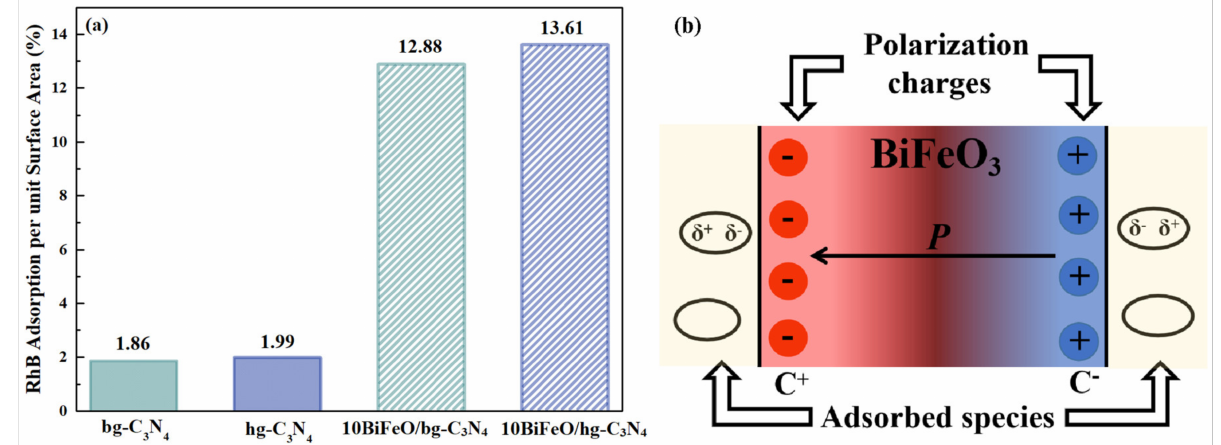
Figure 8. ( a ) Adsorption of RhB by g-C 3 N 4 and BiFeO/g-C 3 N 4 under dark conditions for 30 min; ( b ) internal polarization and adsorption